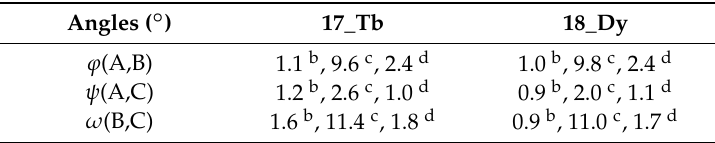
Table 4. Diagnostic angles ( ◦ ) between planes of coordinated and lattice salanH molecules in complexes 17 _Tb and 18 _Dy a